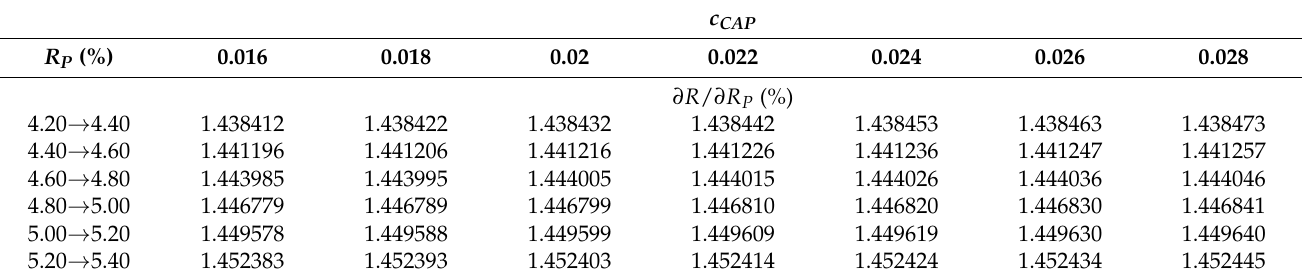
Table 6. Responsiveness of the optimal guaranteed rate to the policy loan rate at various levels of c CAP . c CAP